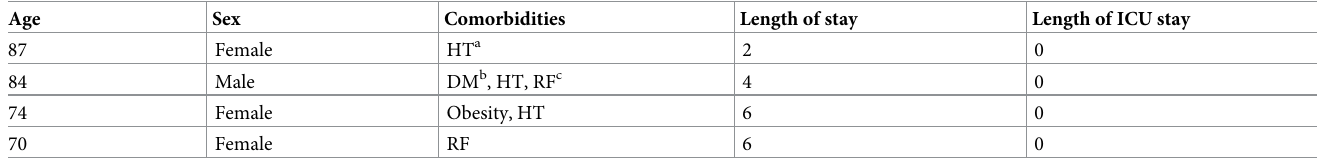
Table 3. Characteristics of the patients who died from